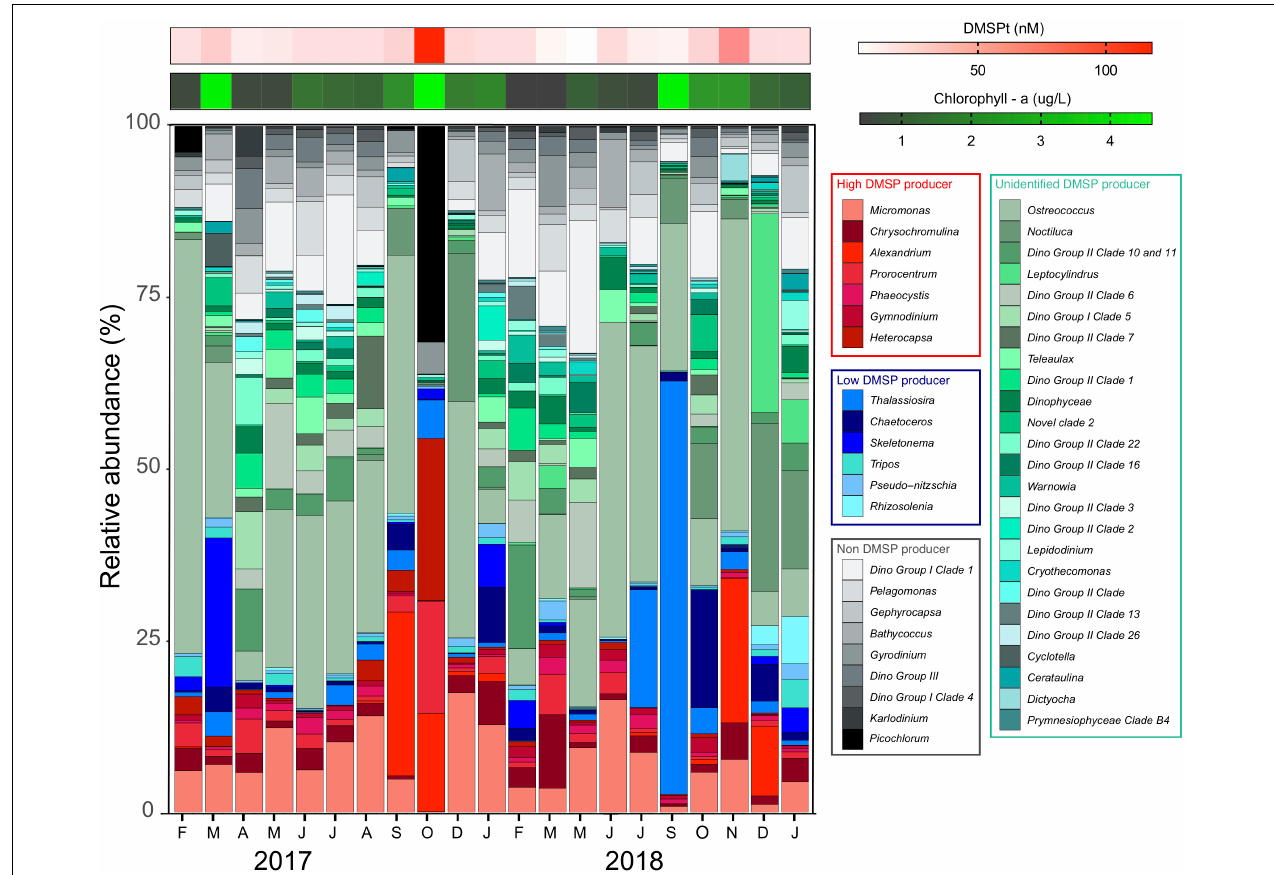
FIGURE 3 | Relative abundance of eukaryotic phototrophs at Port Hacking NRS between February 2017 and January 2019. Phytoplankton taxa assigned as known high DMSP producers (red colors), known low DMSP producers (blue colors), likely producers with unknown DMSP production potential (green colors), and non-DMSP producers (gray-scale colors). Heatmaps represent concentration of total DMSP (red) and chl a